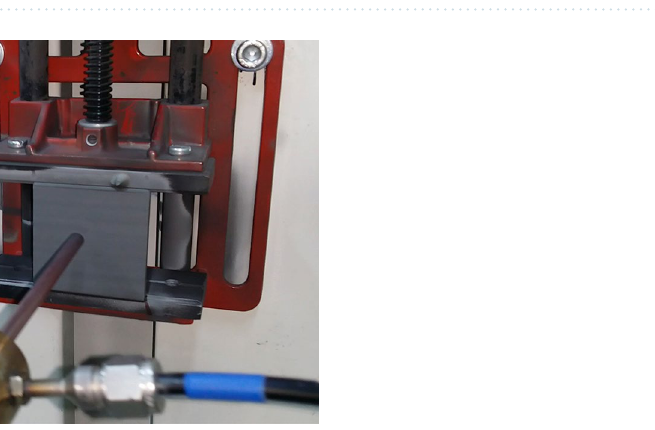
Figure 10. Thermal stabilities, indexed by glass transition temperature (T g ), crystallization temperature (T x ), supercooled liquid region (ΔT x ) of Cu 50 (Zr 50−x Ni x ) MG powders obtained after 50 h of MA time. Differential scanning calorimeter (DSC) thermograms of ( a ) Cu 50 Zr 40 Ni 10 , ( b ) Cu 50 Zr 30 Ni 20 , ( c ) Cu 50 Zr 20 Ni 30 , and ( e ) Cu 50 Zr 10 Ni 40 MG alloys powders obtained after 50 h of MA time. The x-ray diffraction (XRD) pattern of Cu